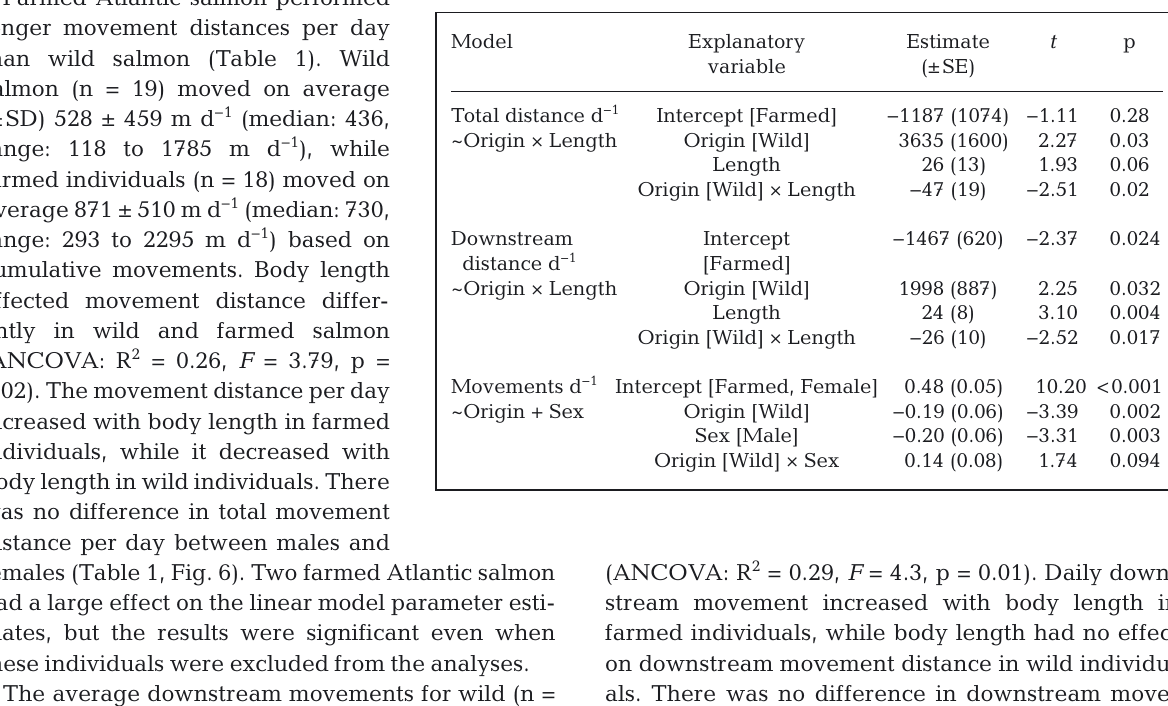
Table 1. Parameter estimates for the most supported linear models to predict total daily movement distance, downstream movement distance and number